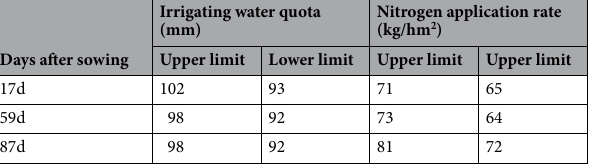
Table 11. Preliminary prediction results of irrigation and nitrogen application